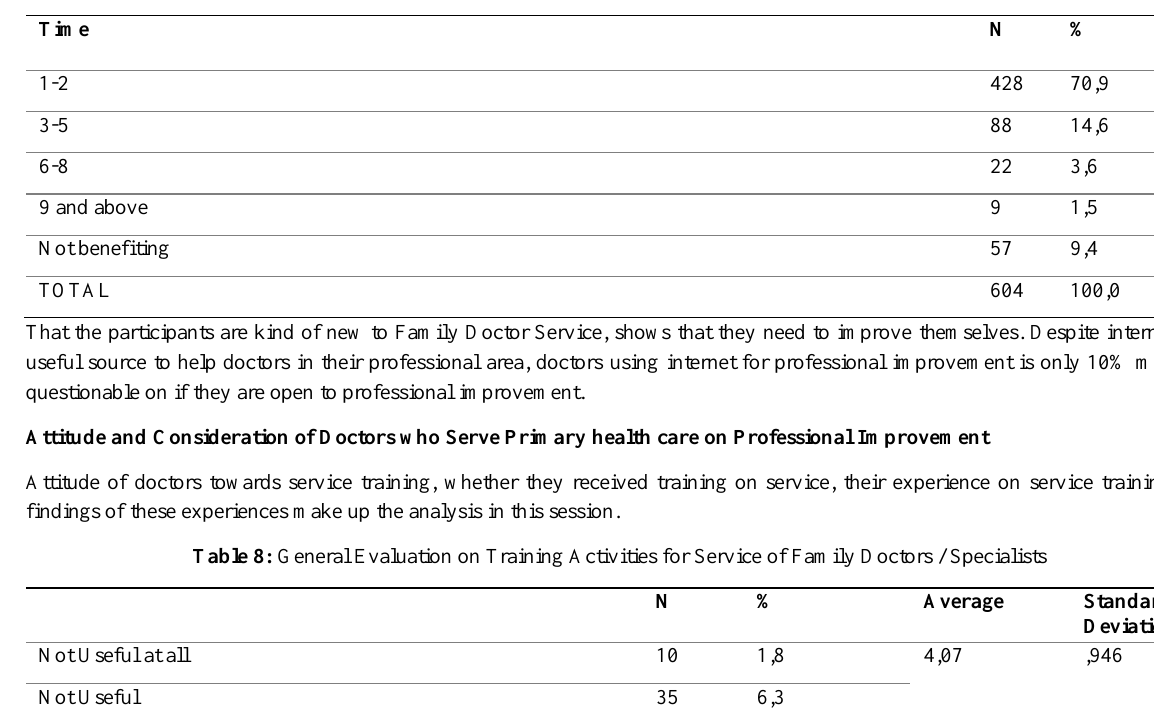
Table 7: Benefiting from Internet for Career Development